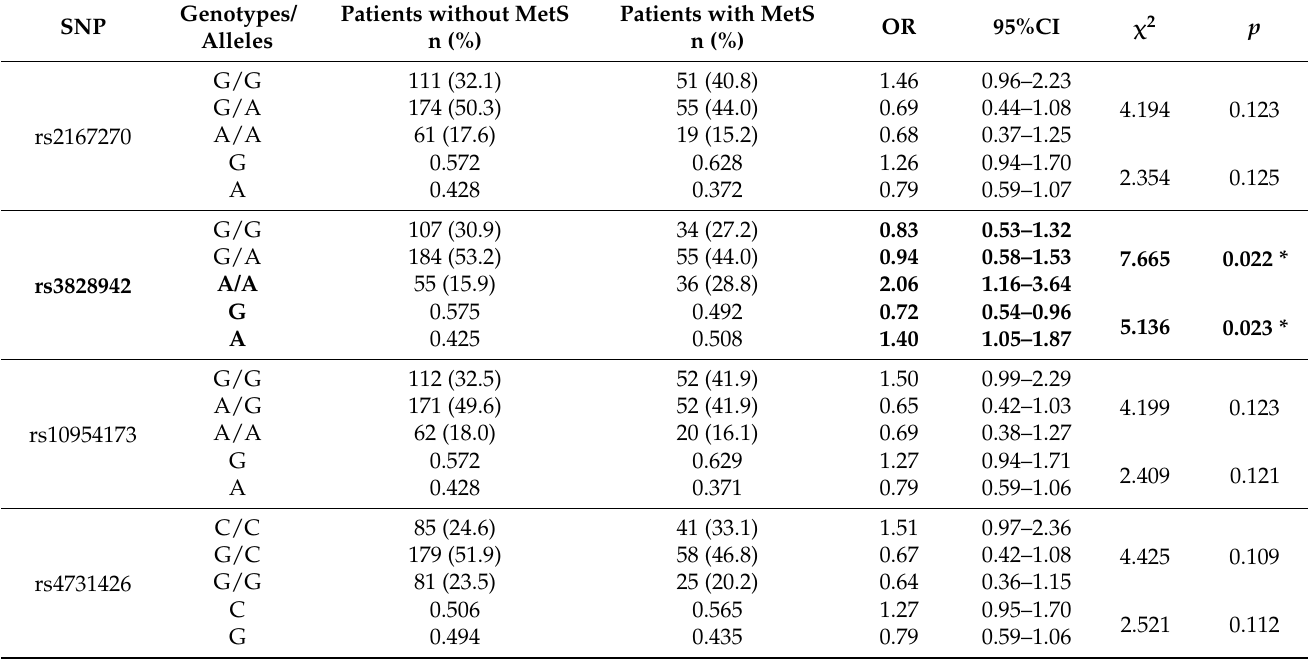
Table 2. Distribution of alleles and genotypes of LEP polymorphisms in groups of patients.